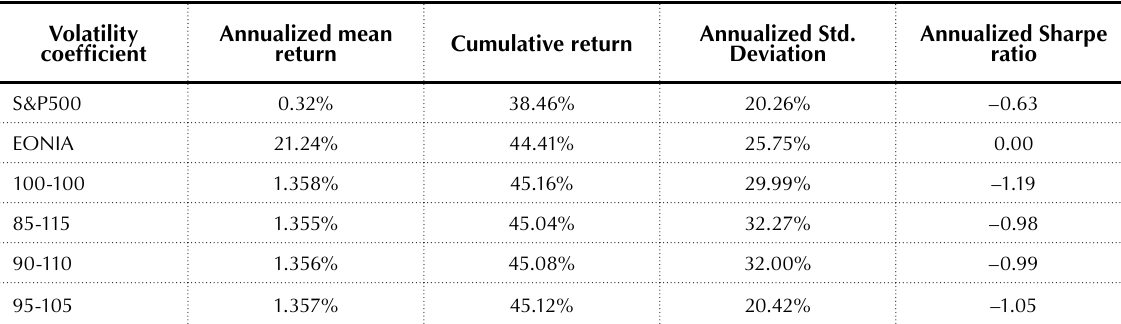
Table 2. Measures of risk and return (6M option)